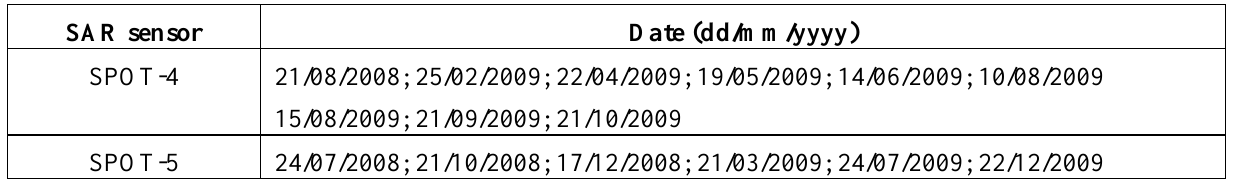
Table 2. SPOT-4 and SPOT-5 images used in this